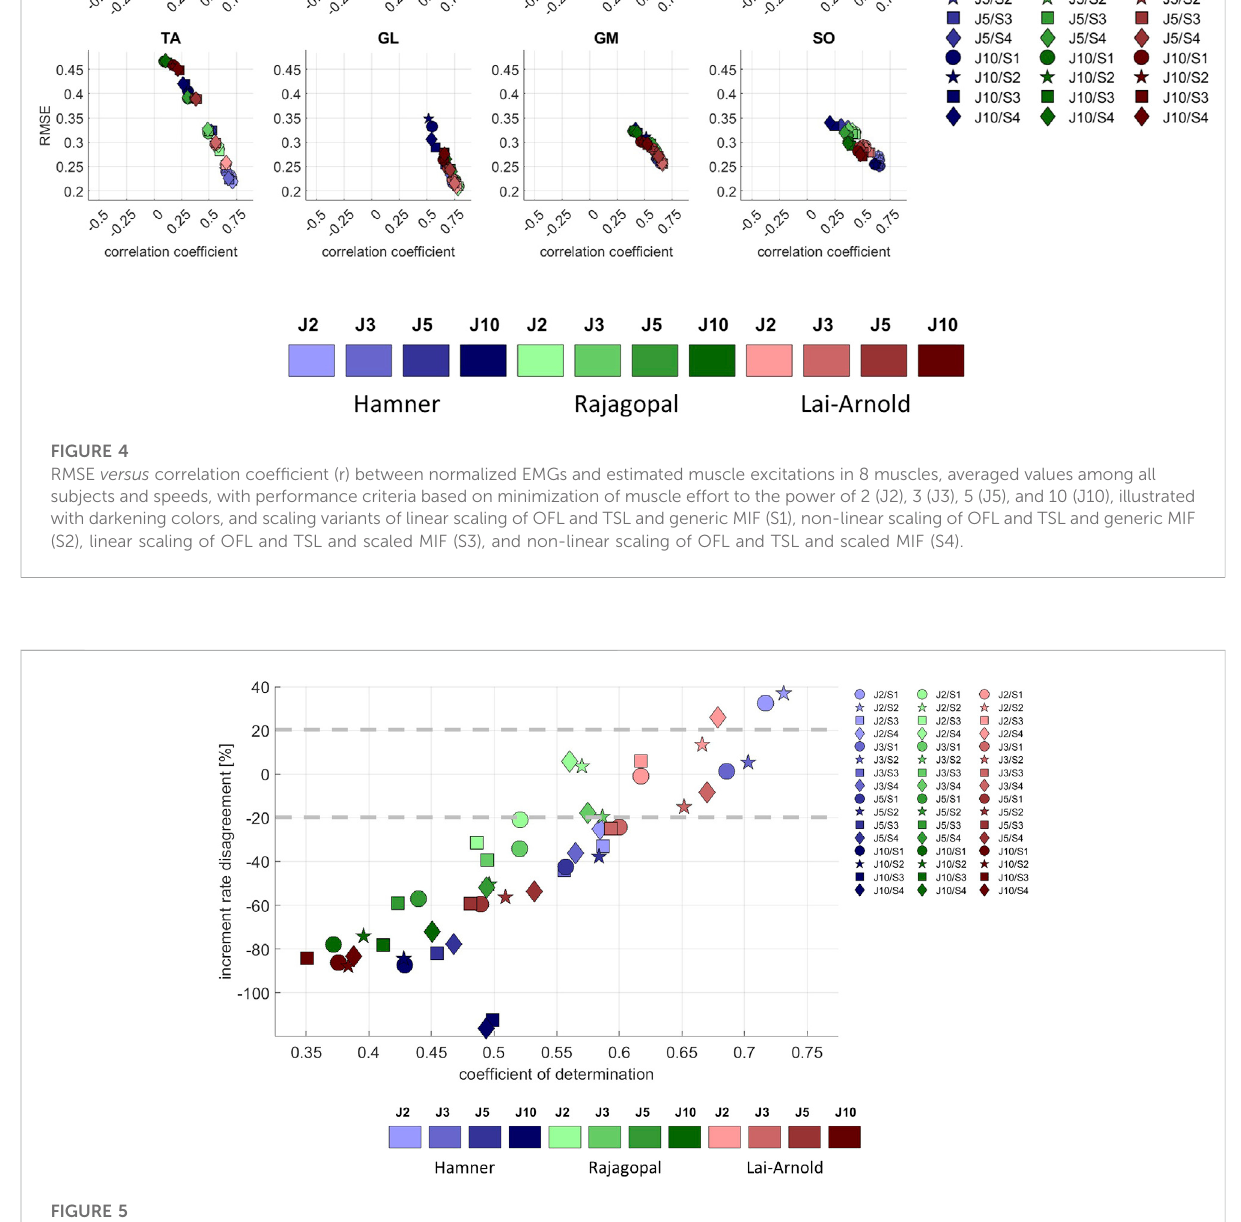
FIGURE 5 Increment ratedisagreement betweenexperimentaland estimatedexcitations versus thecoef fi cient ofdetermination,averagedvaluesamong all subjects, speeds and muscles, with performance criteria based on minimization of muscle effort to the power of 2 (J2), 3 (J3), 5 (J5), and 10 (J10), and scaling variants with linear scaling of OFL and TSL and generic MIF (S1), non-linear scaling of OFL and TSL and generic MIF (S2), linear scaling of OFL and TSL and scaled MIF (S3), and non-linear scaling of OFL and TSL and scaled MIF (S4). The best estimates can be considered to lie approximately +/-